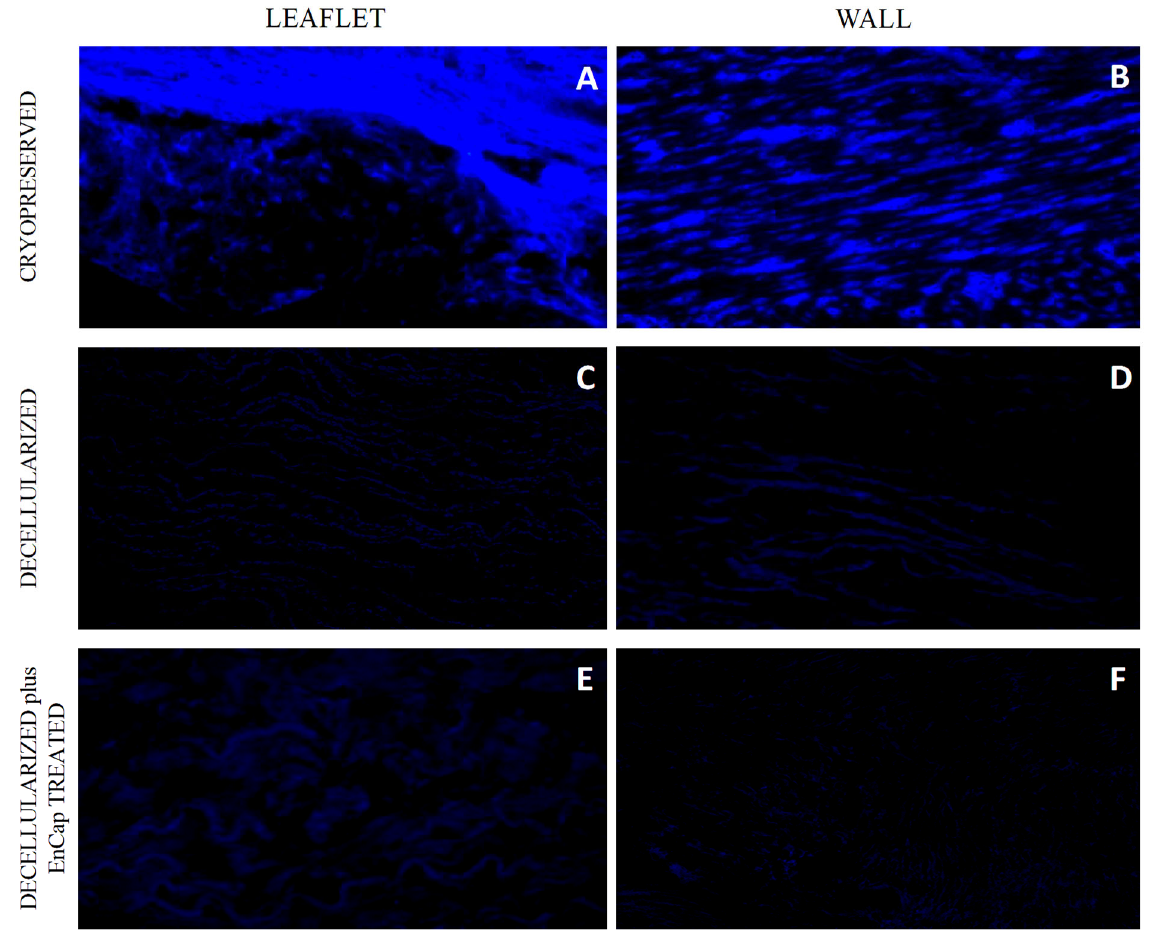
Figure 2. Representative images of DAPI ‐ stained sections of cryopreserved ( n = 5) ( A , B ), decellular ‐ ized ( n = 5) ( C , D ), and decellularized plus EnCap TM_ treated ( n = 5) ( E , F ) leaflet and wall tissue. Gel electrophoresis (fragmented DNA bands < 200 bp) and nanodrop readings of be ‐ low 50 ng/mg for the same tissue samples were used to confirm and support the successful decellularization. The NanoDrop reading for fresh homograft tissue prior to decellulari ‐ zation was 204.8 ng/mg [200.8–212], and following decellularization no DNA was detect ‐ able via NanoDrop. The absence of DNA following the decellularization of homograft tissue was also shown with gel electrophoresis (Figure 3).